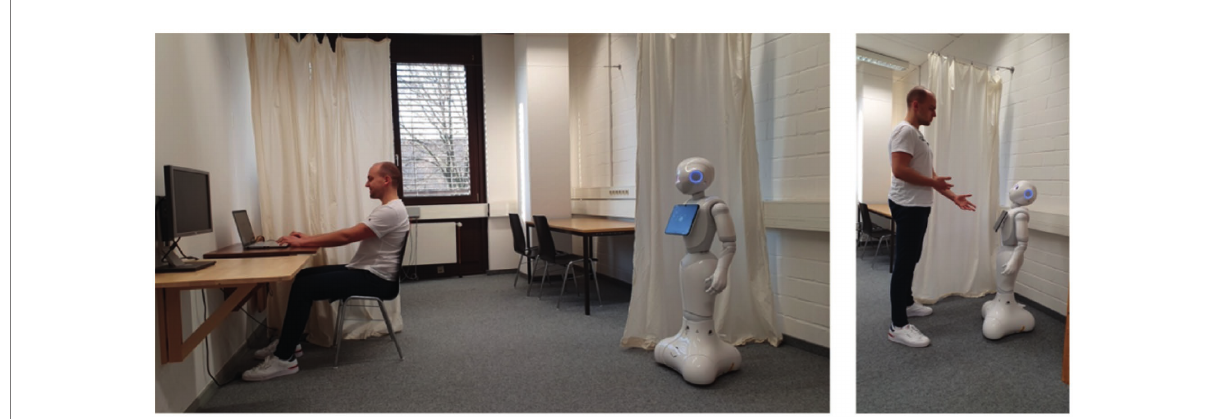
FIGURE 1 Laboratory setting: Participants worked on the questionnaire sitting at the desk and turned to the robot for the recommendation task while the experimenter was in the room next